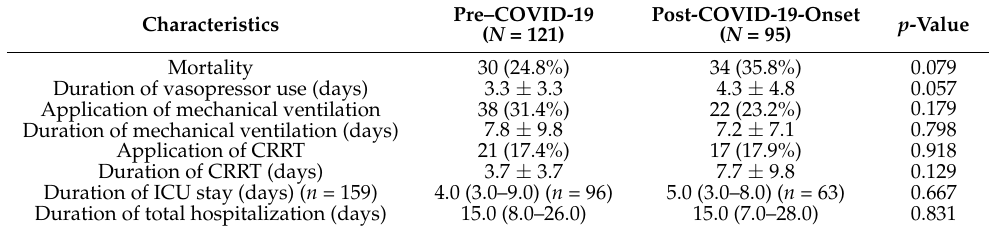
Table 2. Comparison of outcomes between the pre-COVID-19 and post-COVID-19-onset groups. Characteristics